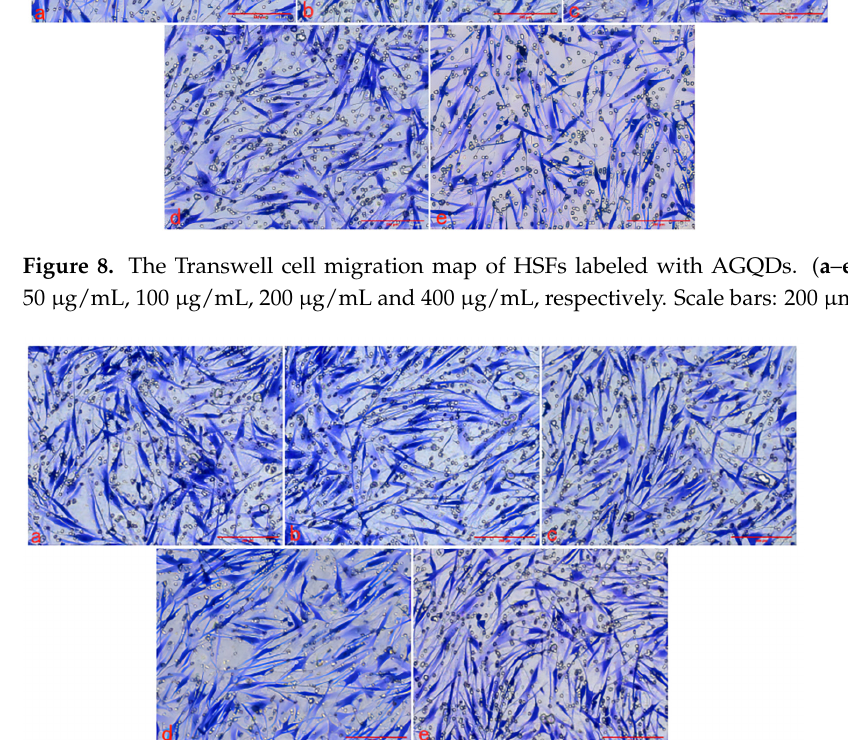
Figure 9. The Transwell cell migration map of HSFs labeled with CGQDs. ( a – e ) are 0 µ g/mL, 50